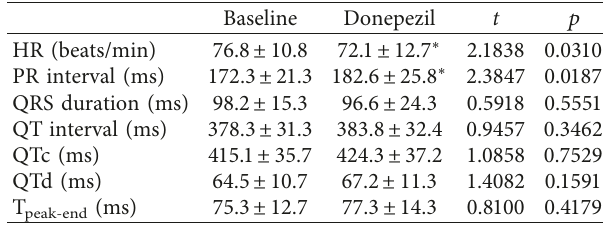
Table 3: ECG parameters at baseline and 4 weeks after donepezil